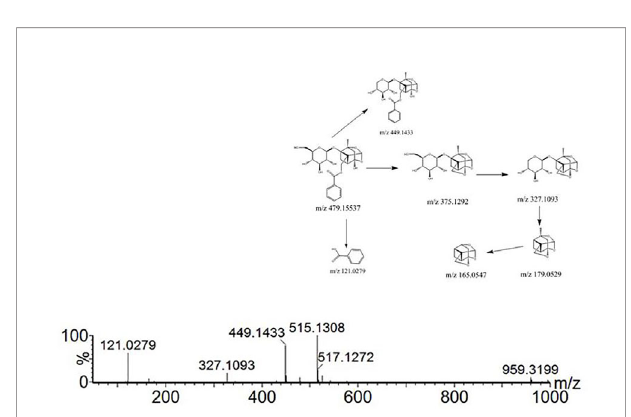
FIGURE 6 | Tandem mass spectra and possible fragment pathways of paeoni fl orin in positive ion